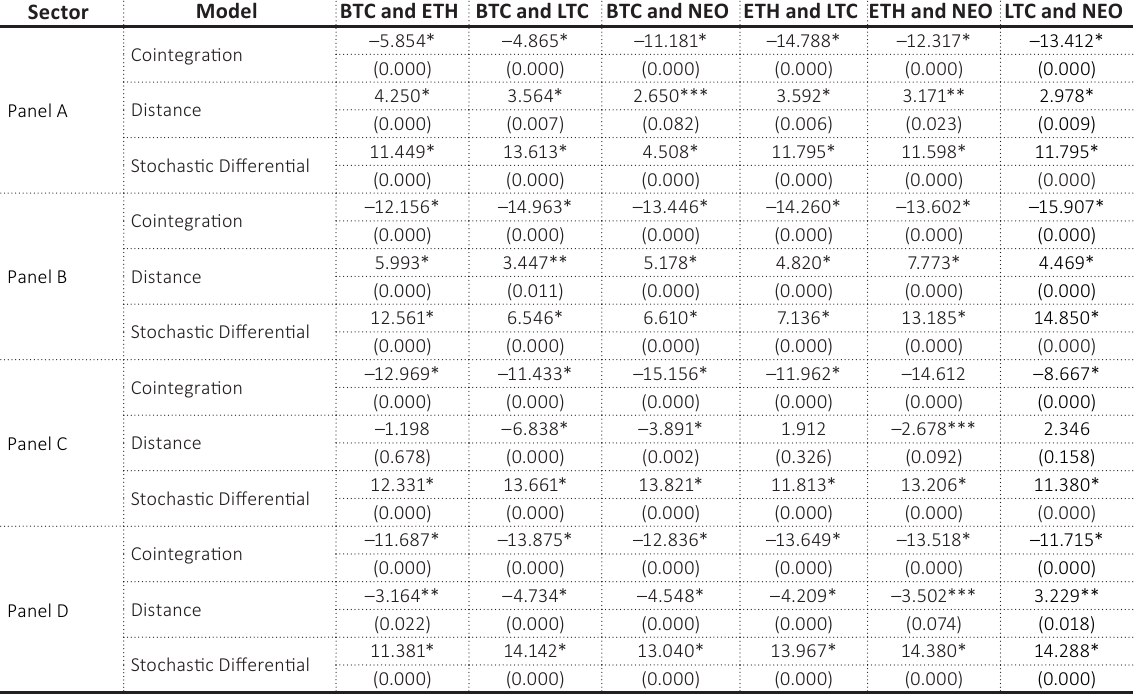
Table 5. Augmented Dickey-Fuller (ADF) tests on residual